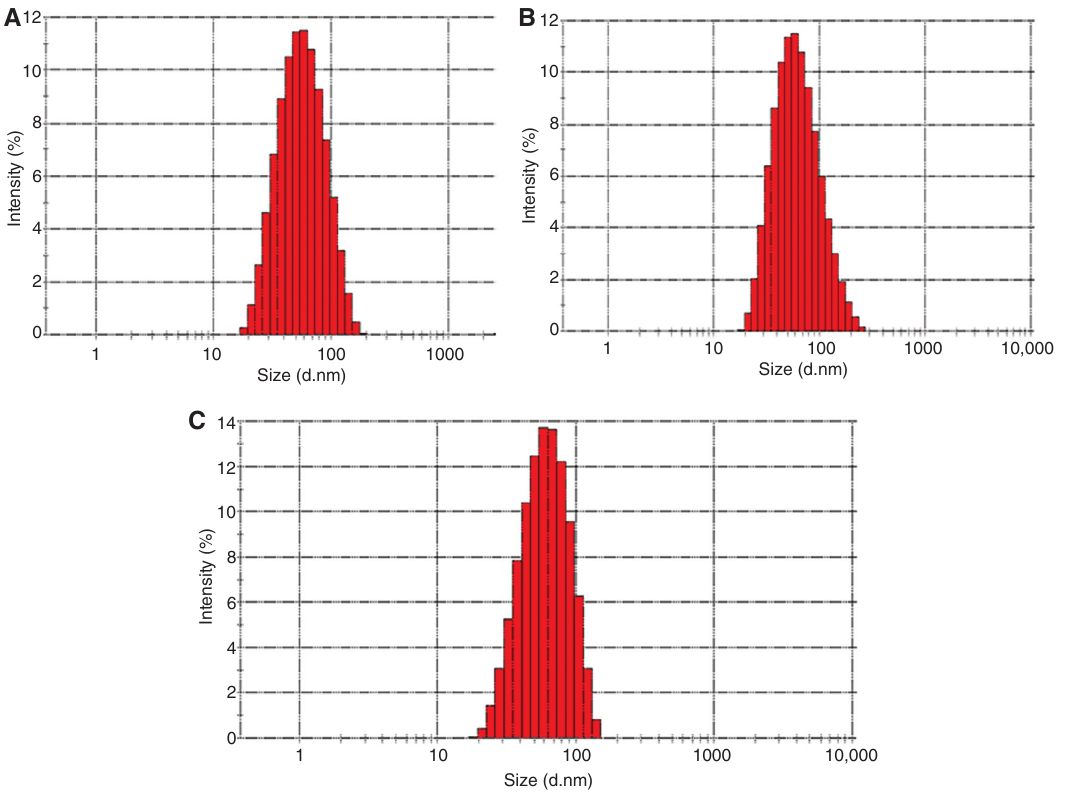
Figure 5 Particle size analysis of (A) gold nanoparticles, (B) PEGylated gold nanoparticles, and (C) BDMCA coated gold